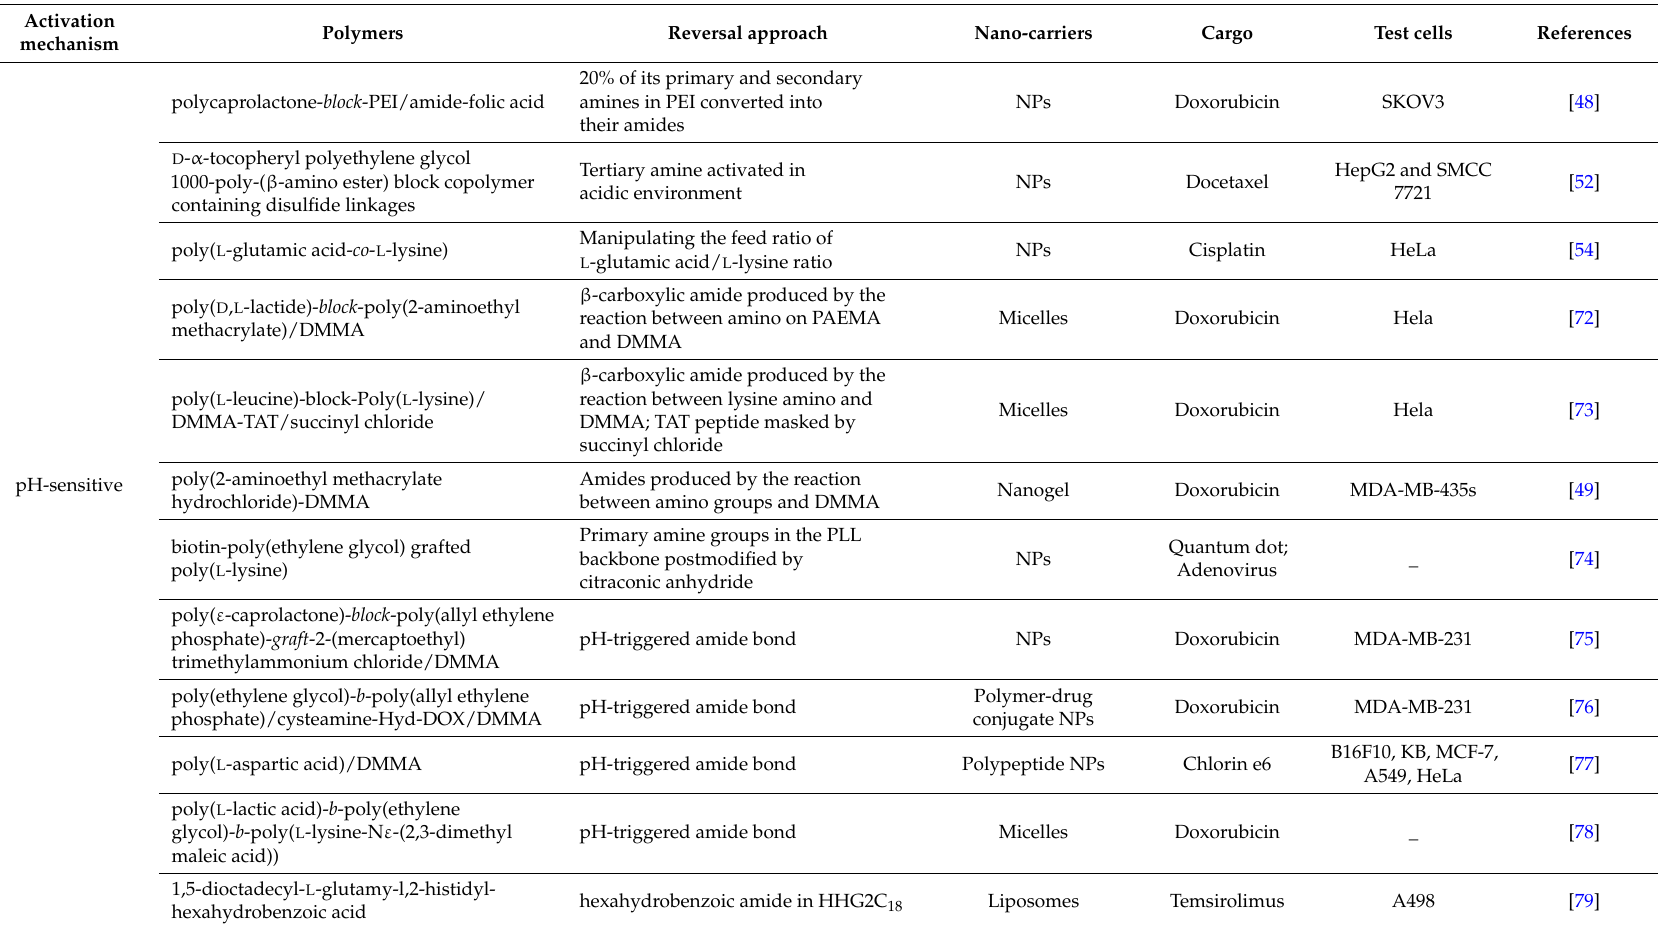
Table 1. Summary of stimuli-activated charge-reversal polymeric nanoparticles for cancer